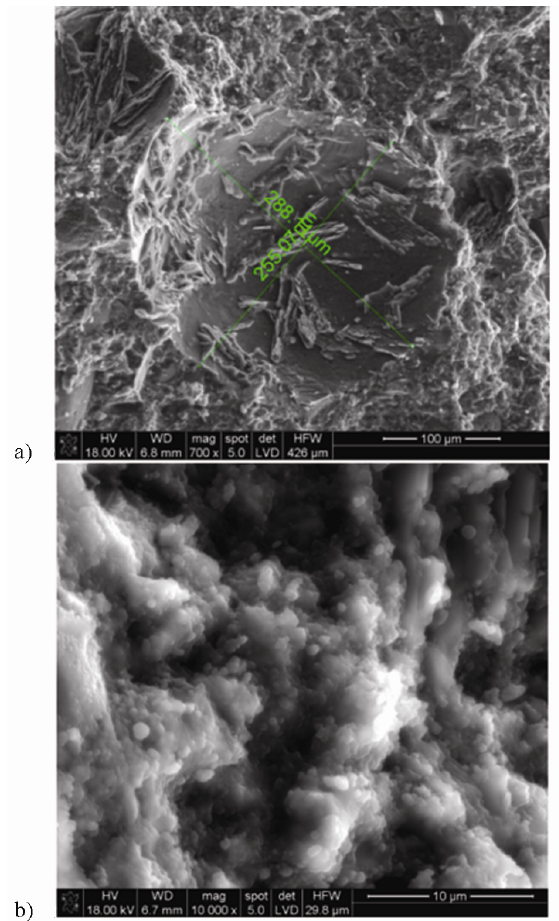
Fig. 15. SEM research results of SCC for air-entraining